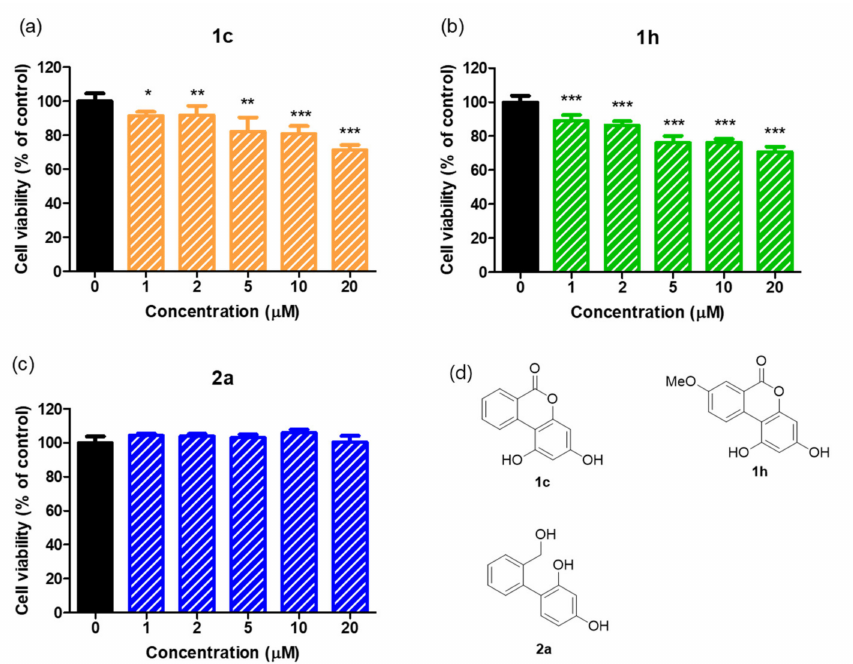
Figure 11. Effects of ( a ) 1c, ( b ) 1h, and ( c ) 2a on murine B16F10 cell viability. ( a – c ) Cells were treated with 1c, 1h, or 2a at 0, 1, 2, 5, 10, or 20 µ M and cell viabilities were determined using EZ-cytox assays. The experiments were conducted independently in triplicate. * p < 0.05, ** p < 0.01, *** p < 0.001, versus untreated controls. ( d ) Chemical structures of 1c, 1h, and